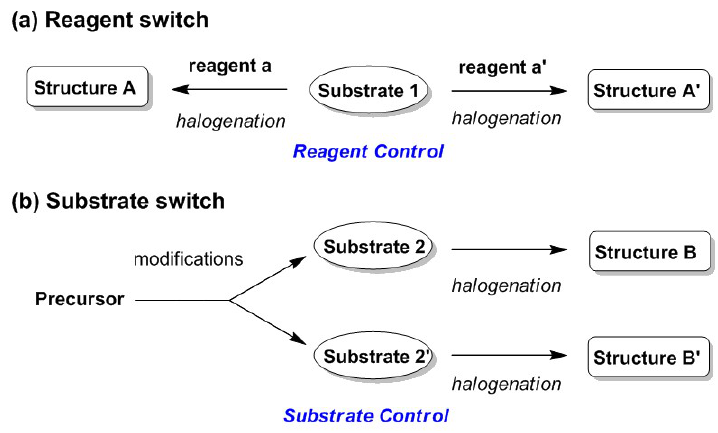
Figure 1. Overall concepts of controllable syntheses: categorized into ( a ) reagent-switchable and ( b ) substrate-switchable strategies.